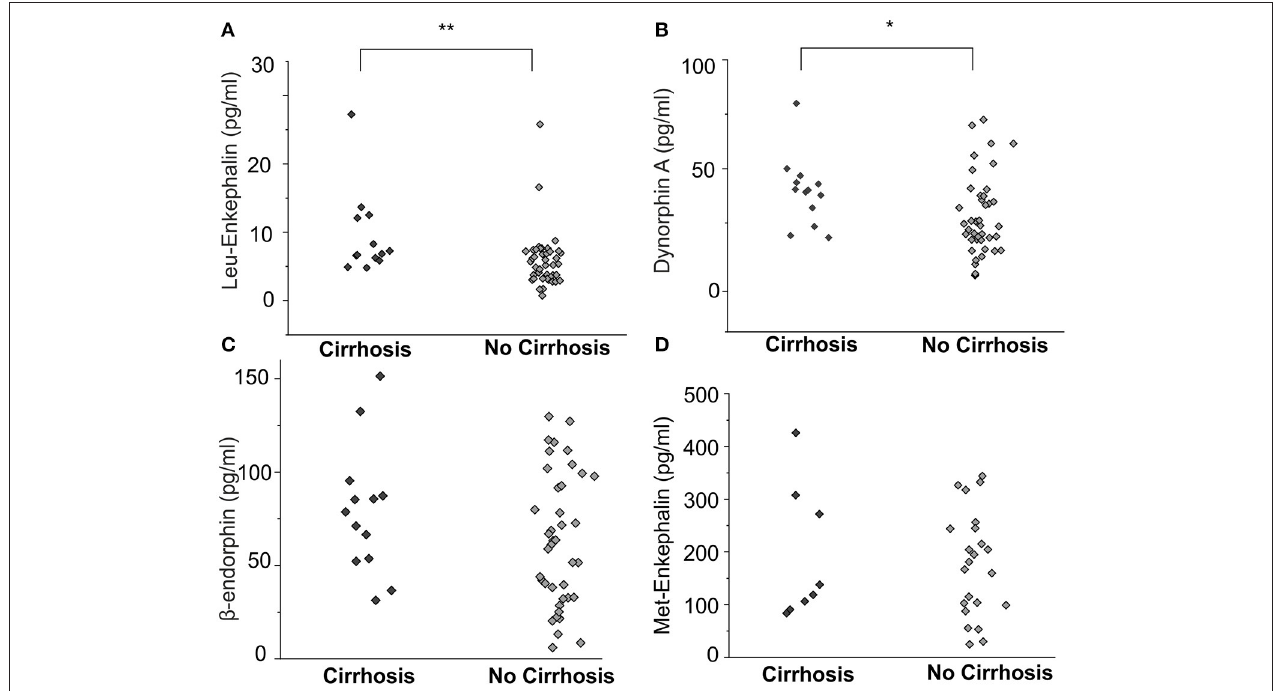
FIGURE 3 | Endogenous opioid plasma levels in patients with cholestatic liver diseases with and without cirrhosis. Leu-enkephalin and dynorphin A concentrations [pg/ml] were significantly higher in patients with liver cirrhosis ( A, B , n = 13) compared to non-cirrhotic patients ( n = 43), but no significant differences were observed for β -endorphin and Met-enkephalin concentrations between those groups (C,D) . Data were statistically analyzed by multi-way analysis of variance (ANOVA) with least significant difference (LSD) post hoc testing. Significant differences are indicated by asterisks: * p < 0.05, ** p < 0.01.